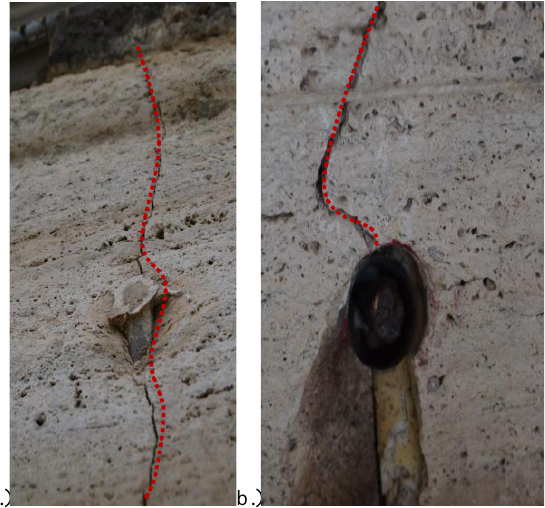
a.) b.) Figure 18. a.) Rebar coming out from the original position, inside of the travertine column and crossed by a sub – vertical crack; b.) Image of the metal bar inside the pillar after removing the cap made by epoxy resin and travertine pieces.